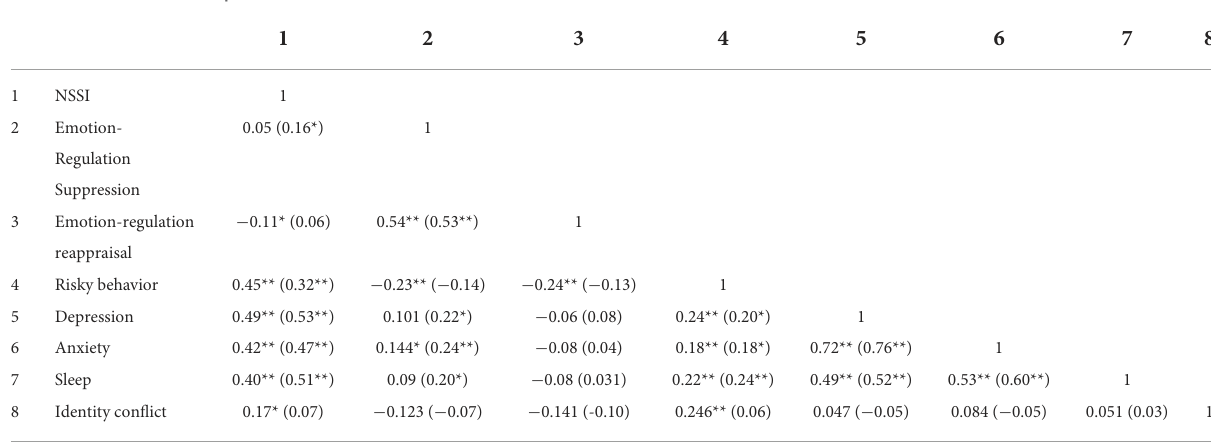
M ± SD,mean ± standarddeviation;NSSI,Non-suicidalself-injury. TABLE 3 Pearson full and partial a correlations between